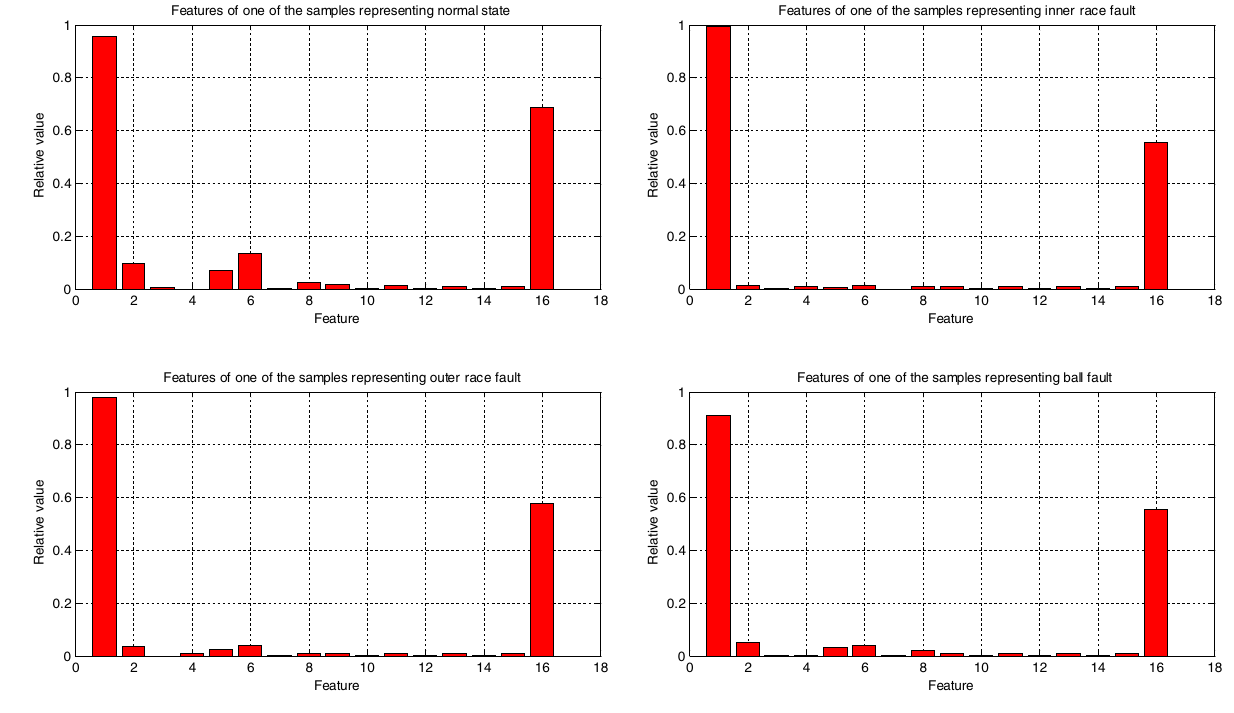
Figure 2. The features of a set of samples with different states by using feature extraction method of time– frequency image based on the preliminary features are processed to avoid the impact of too large numerical span on the classification effect. The mapminmax function in MATLAB shown in Eq. (1) is used to normalize the preliminary features in the training set. As mapminmax function is to normalize each row of data, the matrix composed of the preliminary features in the training set is transformed into a row vector before normalization, and then returned to the form of matrix after normalization. When Eq. (1) is used to normalize the preliminary features in the testing set, the values of x max and x min are the maximum and minimum values among the preliminary features in the training set rather than the testing set.